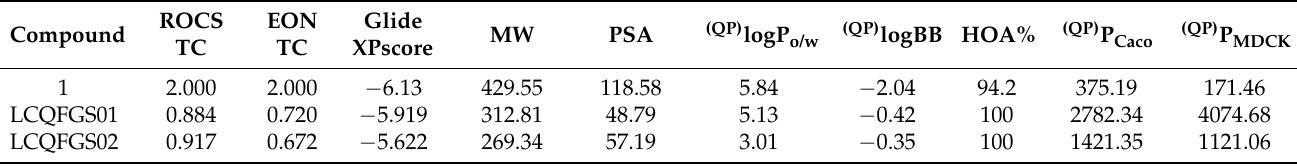
Table 3. Comparison of score values obtained by ROCS, EON, and Glide docking as well as ADME/Tox properties for compounds 1 , LCQFGS01 , and LCQFGS02